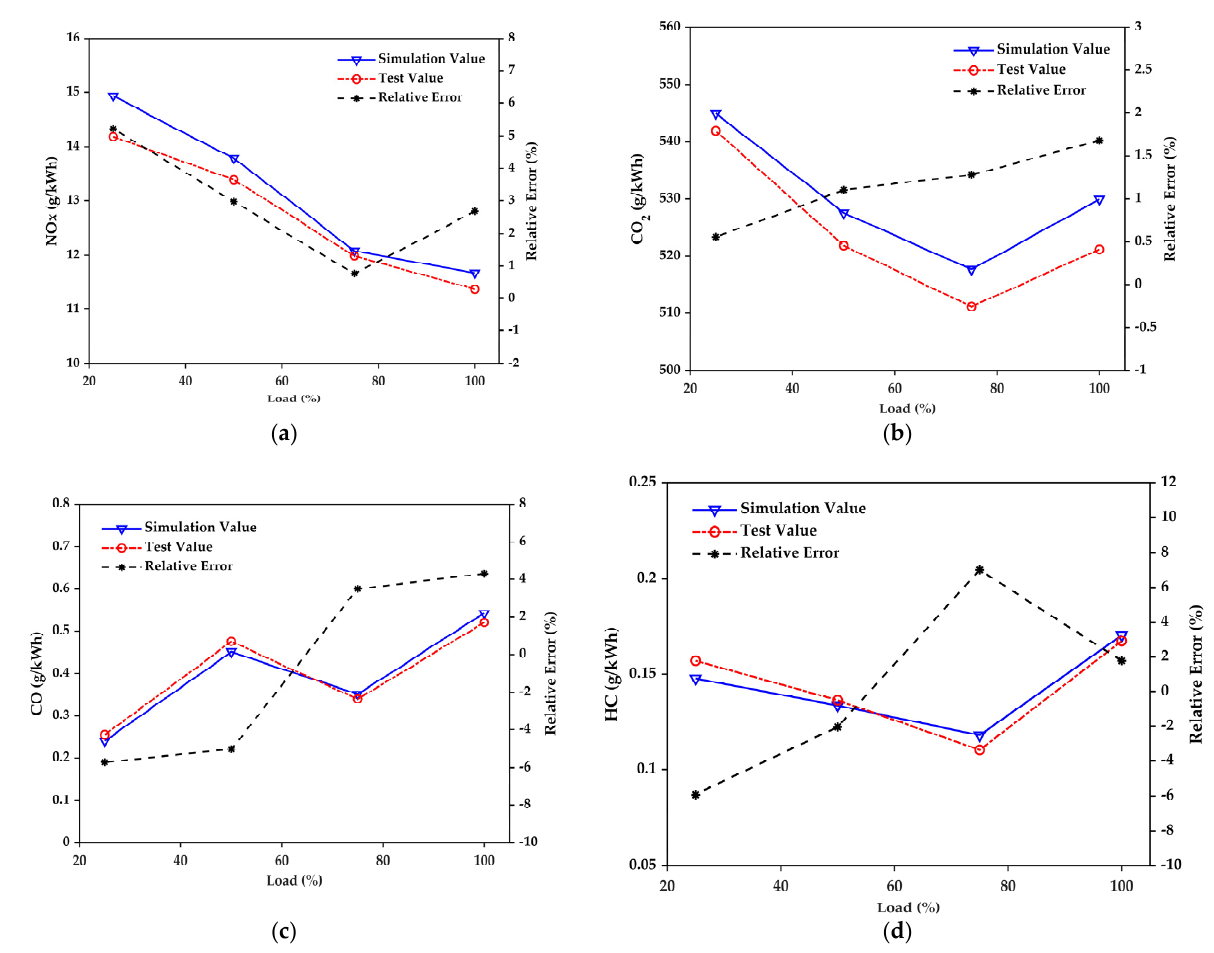
Figure 7. Comparison of simulation results to experimental data in steady ‐ state performance: ( a ) emissions of NO X variation trend with load, ( b ) emissions of CO 2 variation trend with load, ( c ) emissions of CO variation trend with load and ( d ) emissions of HC variation trend with load.